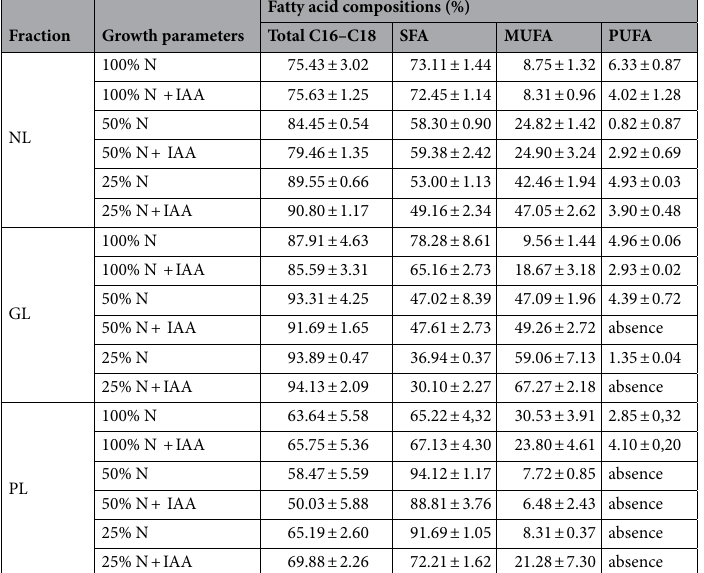
Table 2.. The influence of culture conditions on the fatty acid profile of Eustigmatos calaminaris. Data are expressed as means ( ± SD), n = 9. NL neutral lipids, GL glycolipids, PL phospholipids. SFA–saturated fatty acids, MUFA–monounsaturated fatty acids, PUFA–polyunsaturated fatty